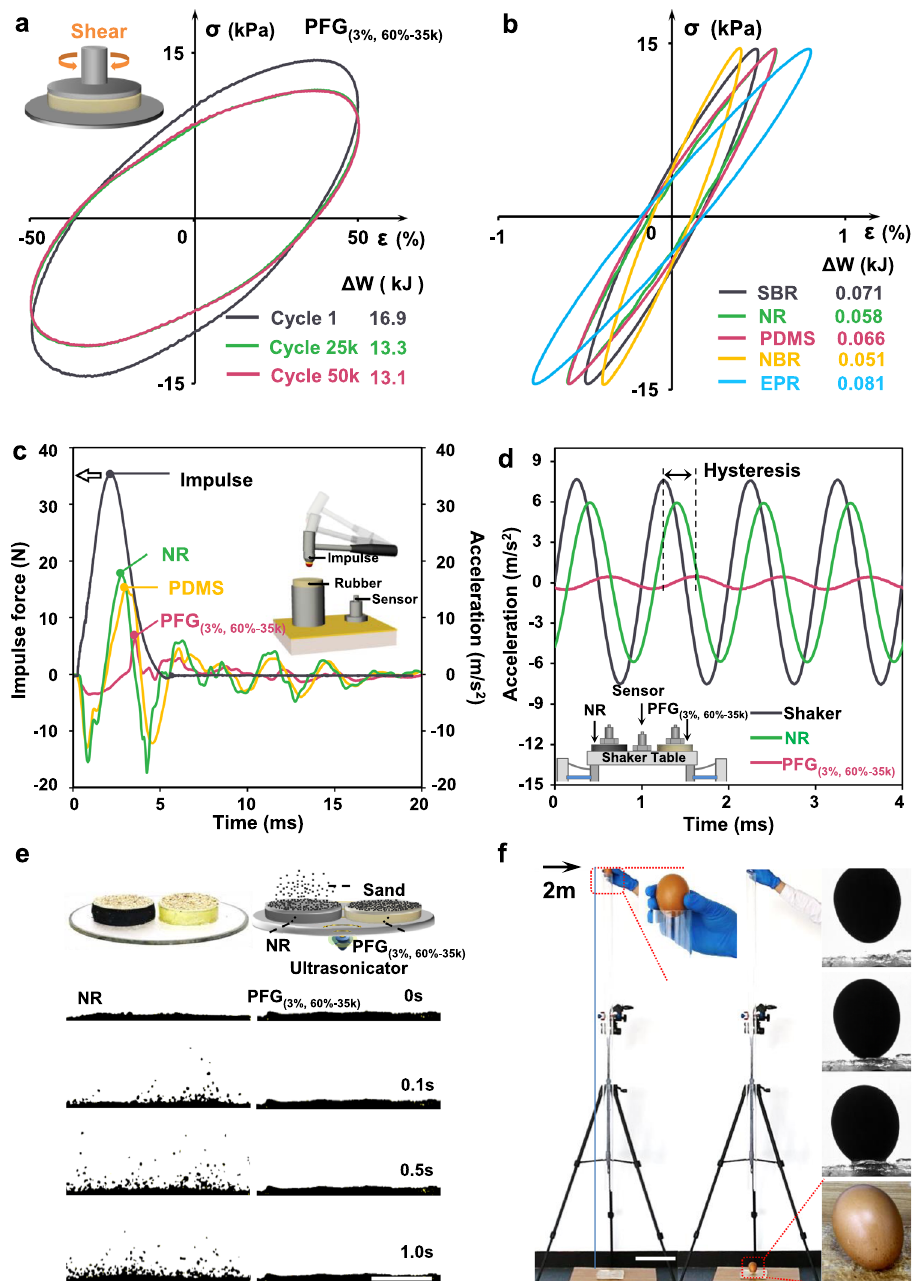
Fig. 5 Shock absorption and vibration damping of polymer- fl uid-gels (PFGs). a , b Large amplitude oscillatory shear (LAOS) tests of damping materials. The hysteresis loops are elliptical, indicating that PFG (3%, 60%-35k) is located in the linear viscoelastic region with 50% strain. The hysteresis loop area represents mechanical energy converted to heat during each cycle and the area is reduced by around 20% after 50 k cycles. The energy dissipation ( Δ W ) of the PFG (3%, 60%-35k) is over 200 times higher than that of commercial damping materials under the same dynamic stress. c Drop weight impact tests on selected damping materials. The PFG (3%, 60%-35k) can reduce the impact force up to 85%. d Shaking table demonstrative experiments of selected